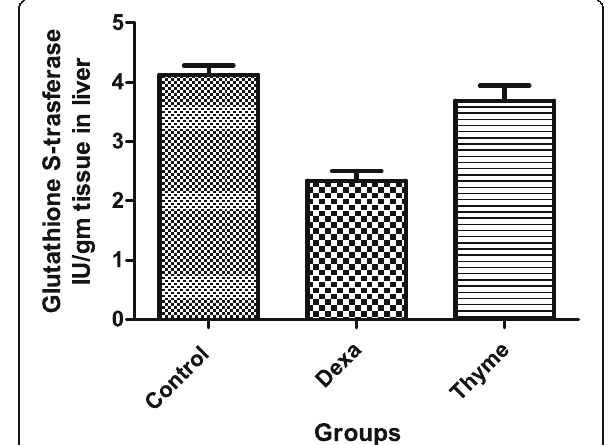
Fig. 7 The defensive role of thyme aqueous extract on liver glutathione S-transferase activity in normal and dexamethasone (DXM)-treated rats. Percentage changes (%) were calculated by comparing normal group with DXM-treated group and pre-treated DXM groups with DXM-treated group